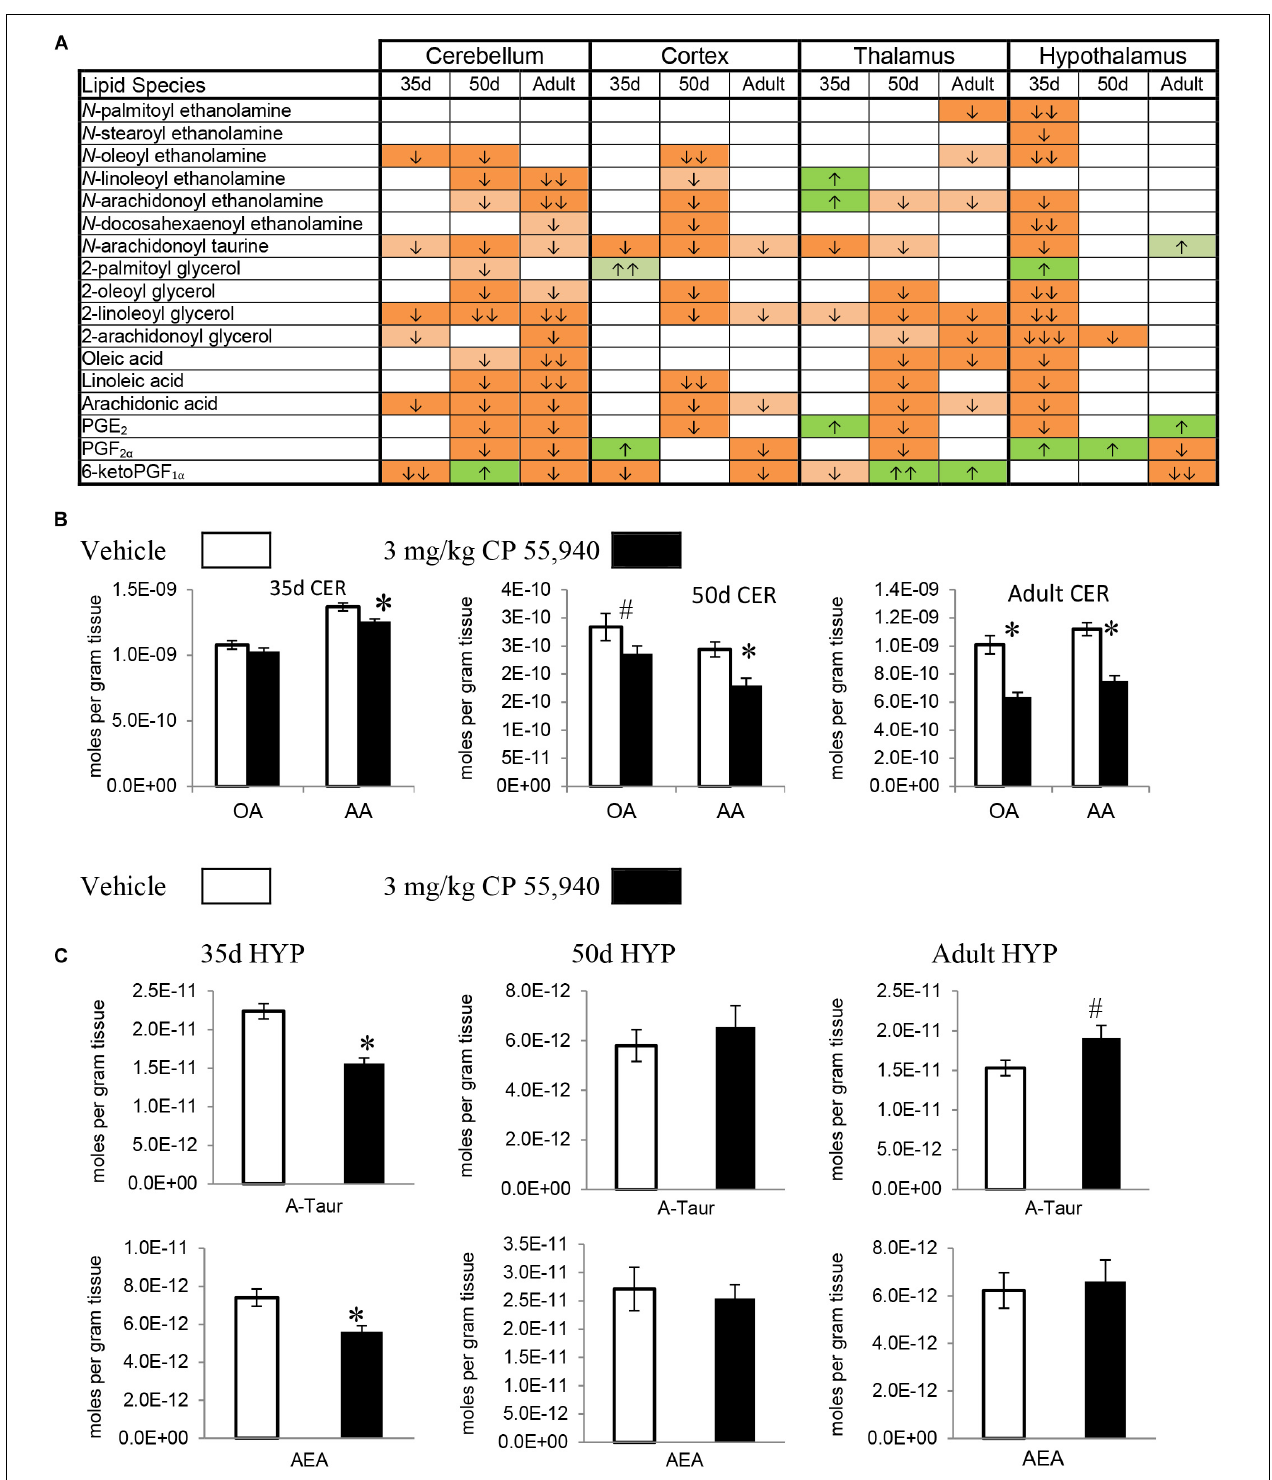
FIGURE 3 | Effects of systemic 3 mg/kg CP 55,940 (CP) on levels of targeted lipids 2 h after injection in the post-natal day (PND) 35, PND 50, and adult CD1 female mouse cerebellum, cortex, thalamus, and hypothalamus. (A) Cells with shaded arrows indicate a change for that lipid in the CP-exposed brain area relative to the same vehicle-exposed area within each age group (35d = PND 35, 50d = PND 50). The arrow color indicates the direction of a significant result relative to control. Green colors represent increases, with darker green representing a significant increase of p < 0.05 and lighter green representing a trending increase of p < 0.10. Orange colors represent decreases in a lipid’s concentration, with darker orange indicating a significant decrease of p < 0.05 and light orange representing a trending decrease of p < 0.10. The number of arrows indicates the magnitude of the difference between CP and